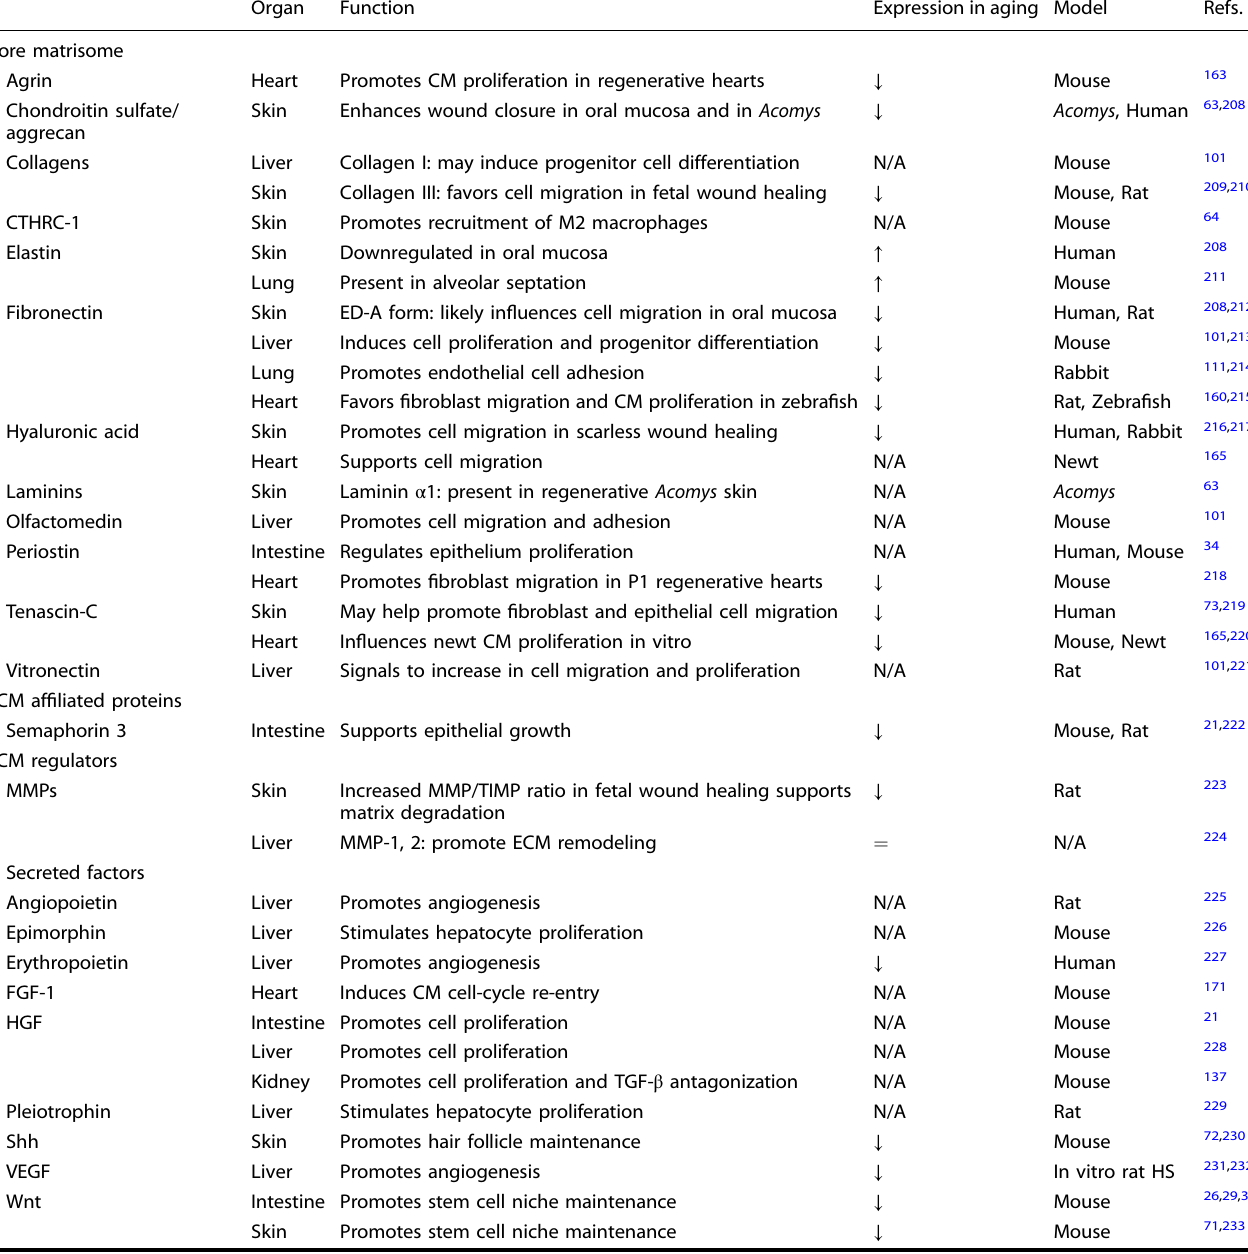
Table 1. ECM-associated molecules 207 involved in the regeneration in in vivo studies of different organs and their transcriptional regulation with